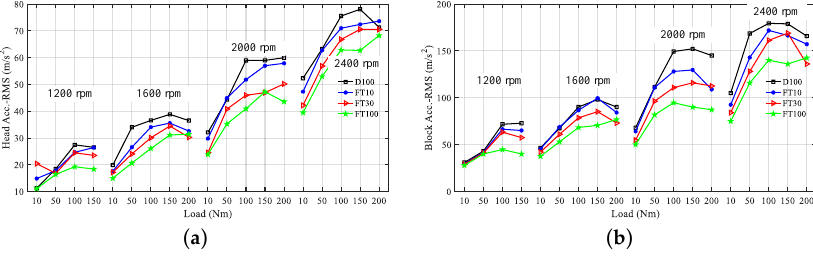
Figure 6. ( a ) RMS value of engine head vibration signal under different working conditions; ( b ) RMS value of engine block vibration signal under different working conditions.